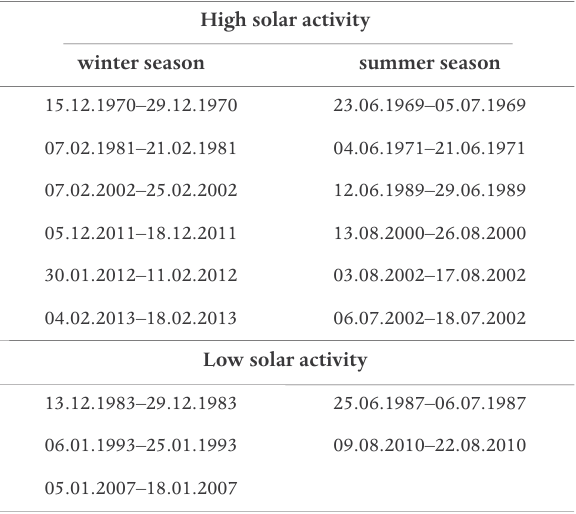
Table 2. Time intervals of foF2 data used for model diagnostics.